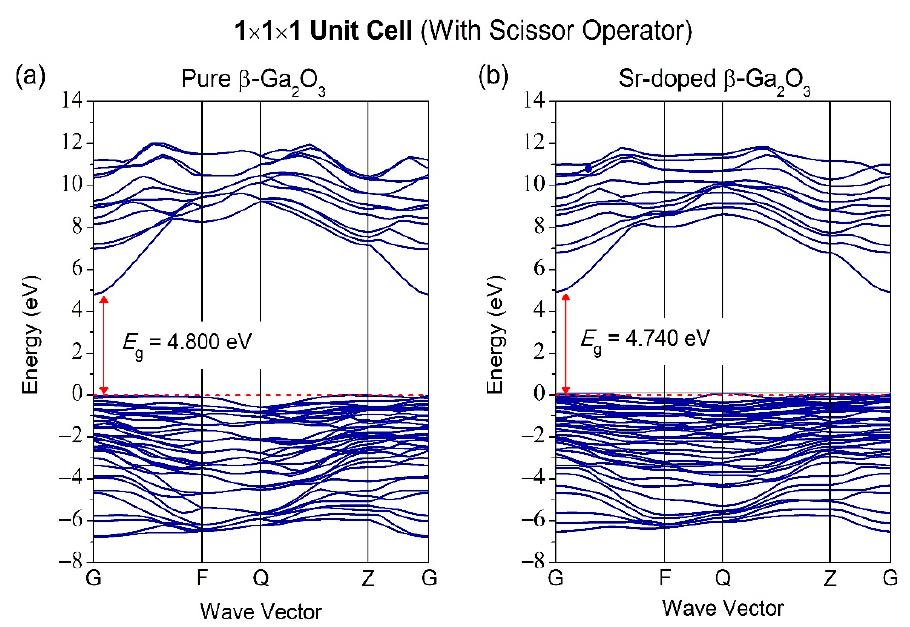
Figure 6. Band structure of ( a ) pure β -Ga 2 O 3 and ( b ) Sr-doped β -Ga 2 O 3 with scissor operator. As for Figure 7, it is the band structure for 1 × 2 × 2 supercell for pure and Sr-doped β -Ga 2 O 3 . Pure β -Ga 2 O 3 has a bandgap of 1.932 eV. On the other hand, the Sr-doped at different doping sites at Ga1 and Ga2 have bandgaps of 1.826 and 1.840 eV, respectively. The band structure for unit cell and supercell show slight differences in bandgap, according to this investigation. For band structures with scissor operator of 1 × 2 × 2 supercell for pure and Sr-doped β -Ga 2 O 3 in Figure 8, the bandgap of pure β -Ga 2 O 3 in 1 × 2 × 2 supercell is 4.8 eV, and the bandgap of Sr-doped β -Ga 2 O 3 at Ga1 and Ga2 is 4.694 and 4.708 eV, respectively.